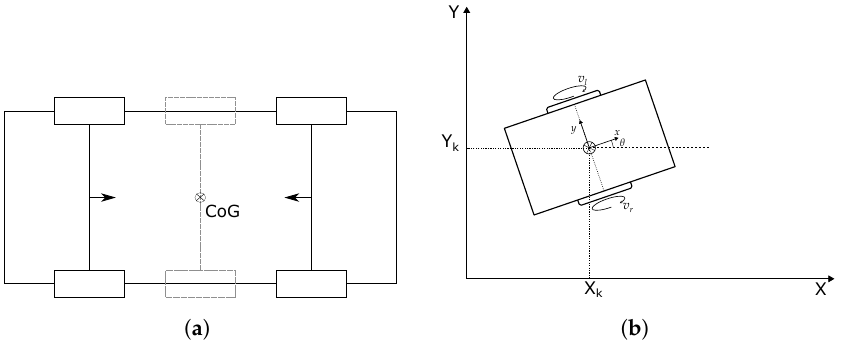
Figure 1. ( a ) Representation of the mini-car. Since the wheels on the same side always have the same rotation speed, it is possible to have one wheel per side located next the CoG. ( b ) Scheme representing the mechanical aspects involved in the model defined by